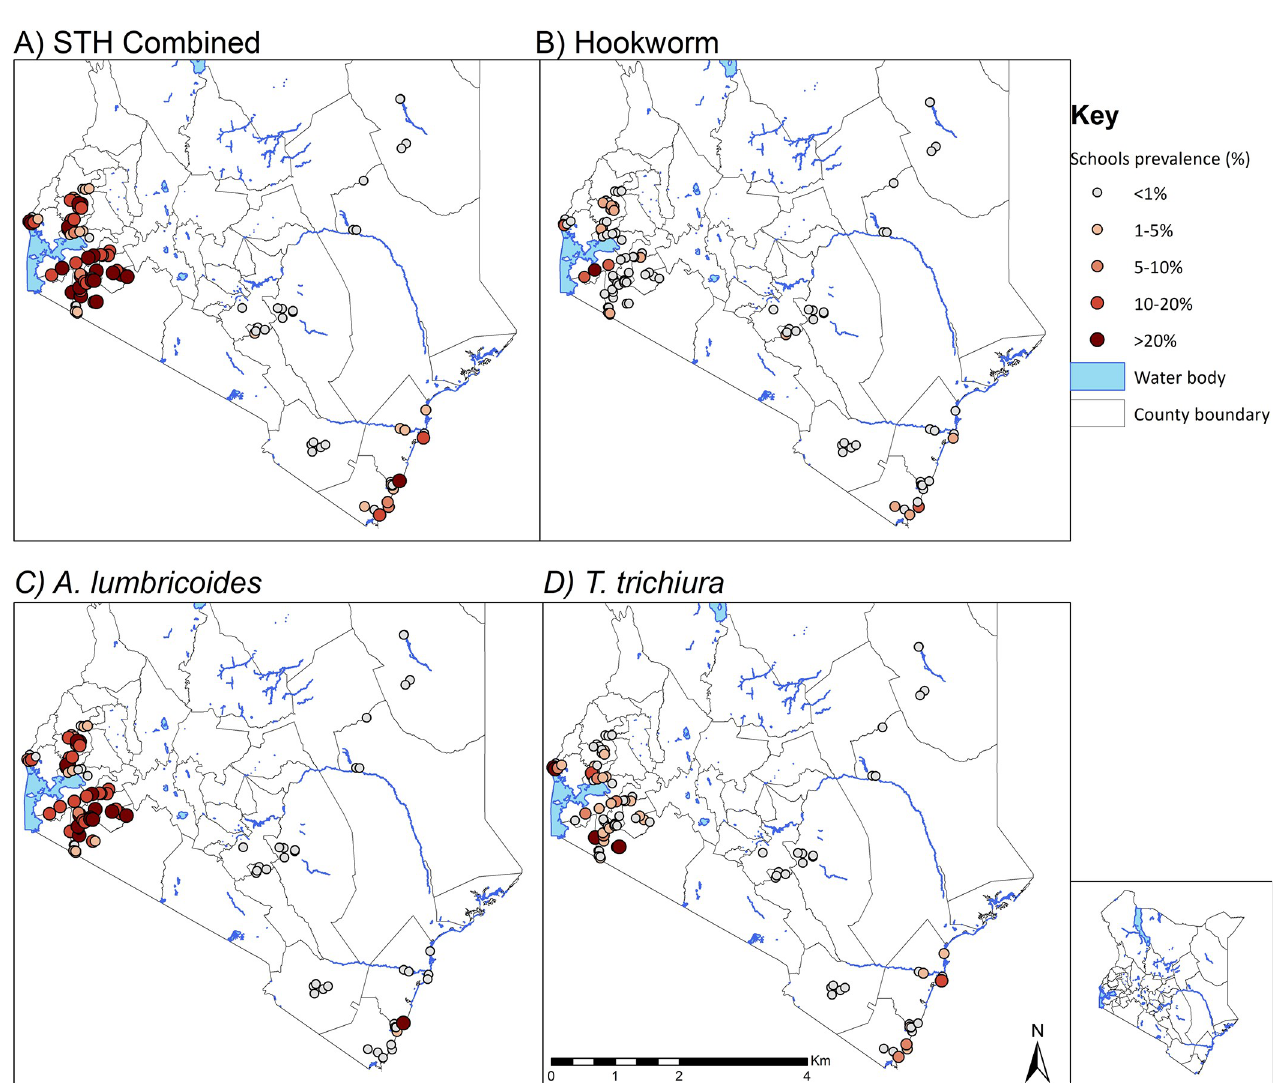
Fig 1. STH Prevalence distribution after five years of deworming in Kenya.